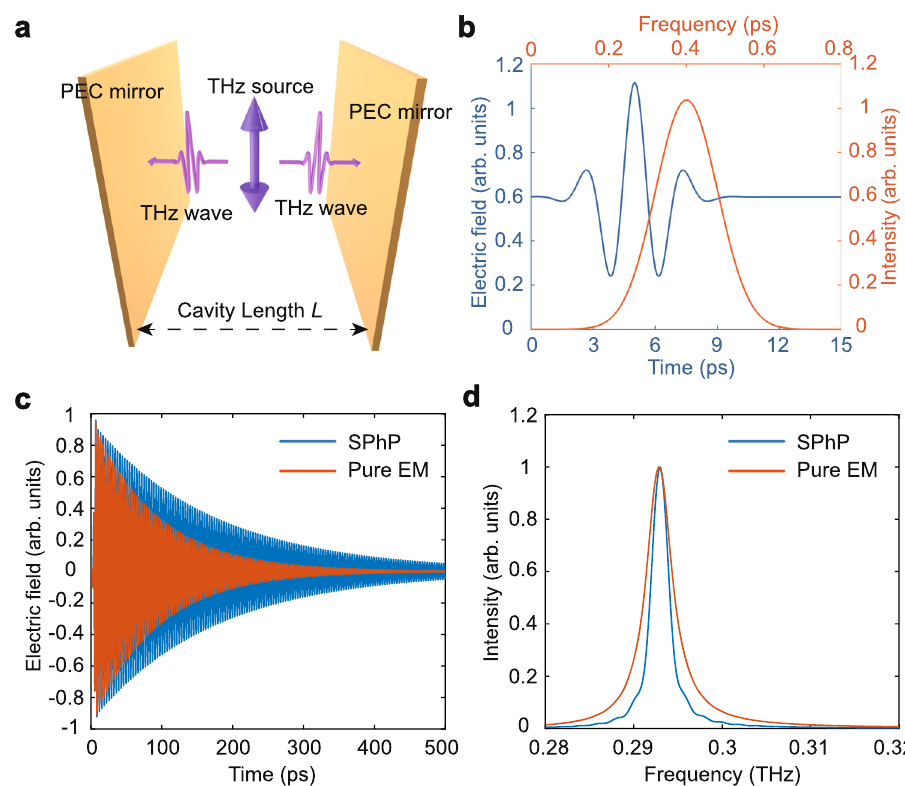
Fig. 2 Stimulated phonon polariton-mediated light – matter interaction in an ideal one-dimensional Fabry – Perot microcavity. a Diagram of the ideal Fabry – Perot microcavity with cavity length L ¼ 200 μ m. An absorption medium is placed between two perfect electrical conductor boundaries. A broadband THz source is placed in the middle of the microcavity. PEC: perfect electric conductor. b Temporal trace and spectrum of the source emitted THz wave. c Decay of the electric fi eld in the microcavity with and without considering the stimulated phonon polaritons. d The Fourier spectra of c .